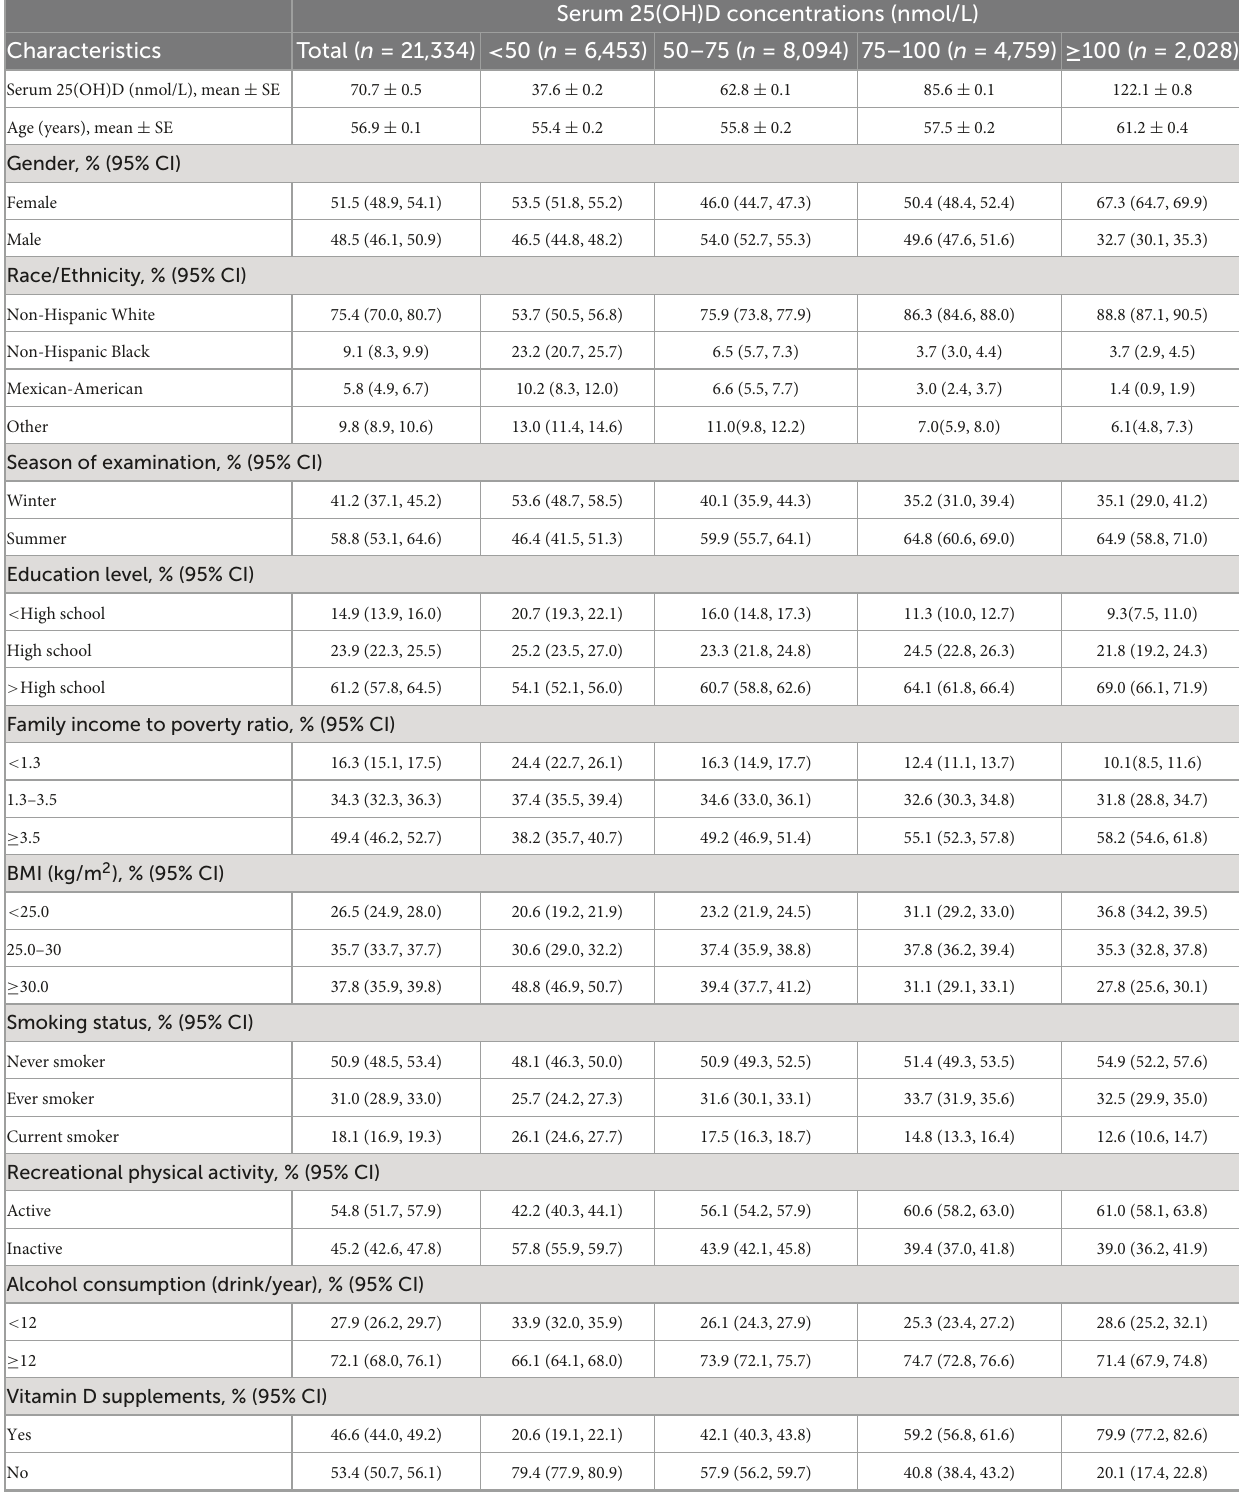
TABLE 1 Baseline characteristics of participants aged ≥ 40 years with or without osteoarthritis according to serum 25(OH)D concentrations in NHANES